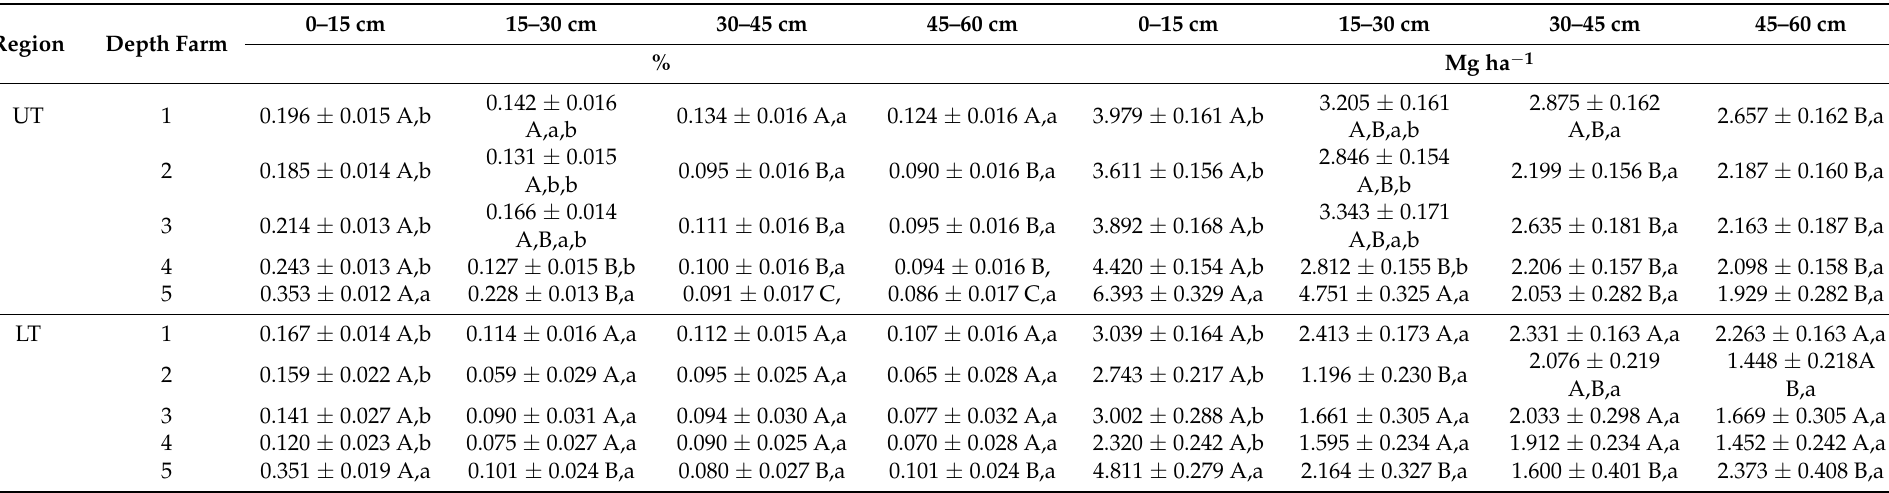
Table 7. Interactive effects of farm x depth on total N contents and stocks (mean ± standard error) under mixed pastures in the Upper (UT) and Lower (LT) Tsitsikamma dairy